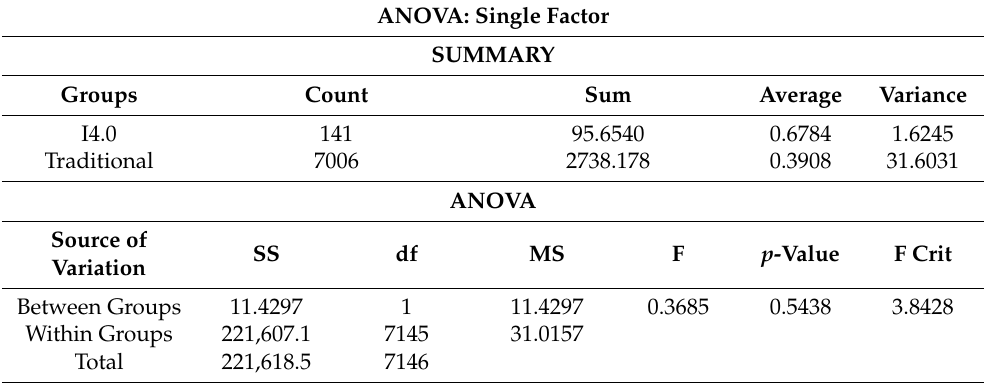
Table 5. ANOVA of the marginal rate of technical substitution.